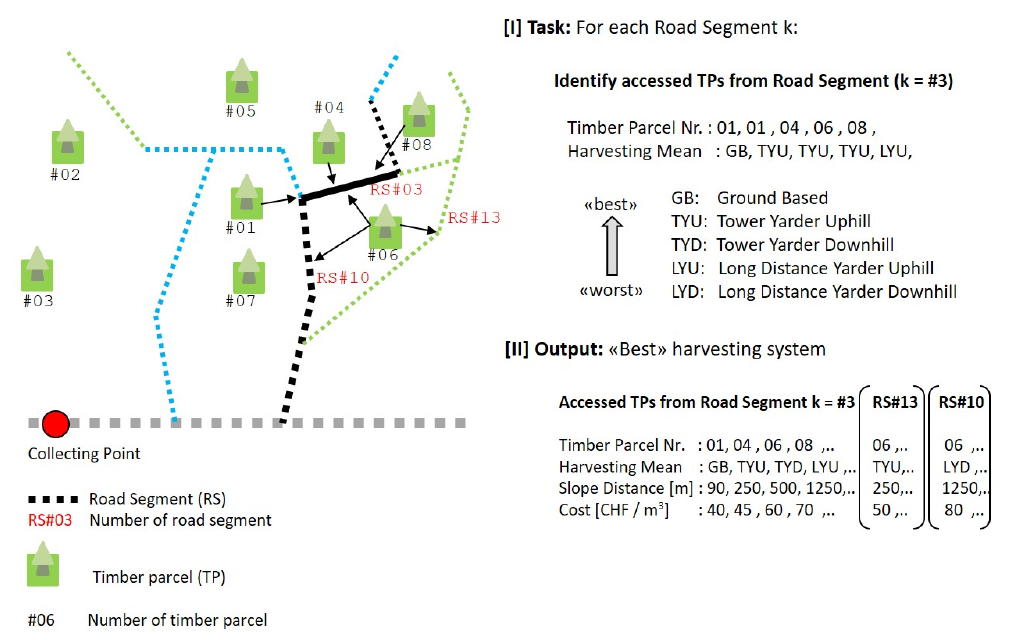
Figure 2. Task and output of the model subsystem “harvesting options”. TPs that could be accessed with the available harvesting systems are identified.